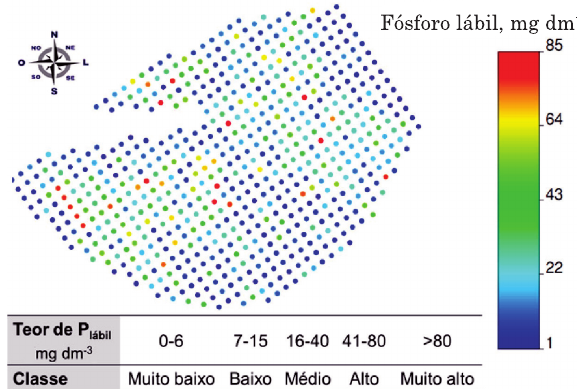
Figura 2. Mapa de distribuição dos teores determinados de fósforo lábil e das classes de teores para o método da resina trocadora de íons para a cana-